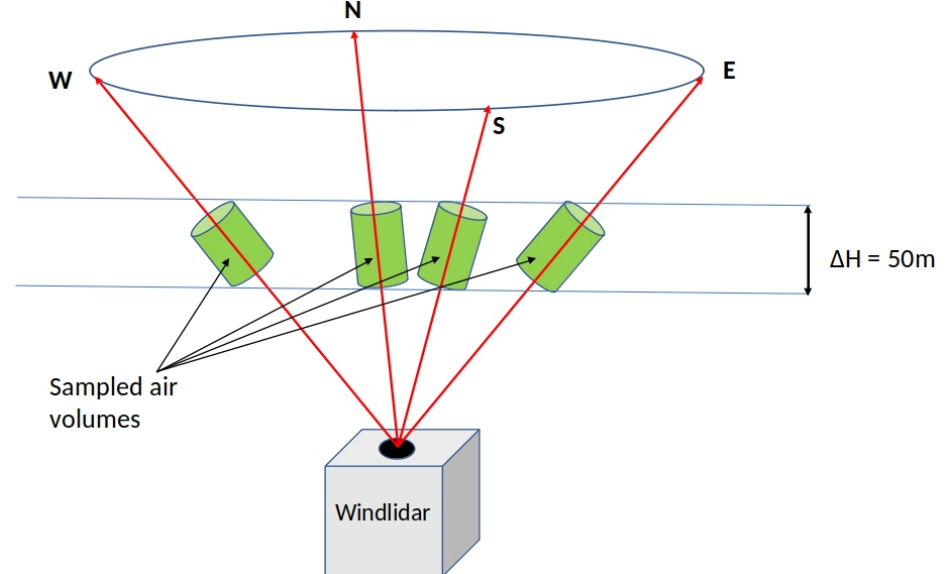
Figure 1. Measurement principle of the windlidar. Obviously not exact the same air mass is measured, when the instrument performs a